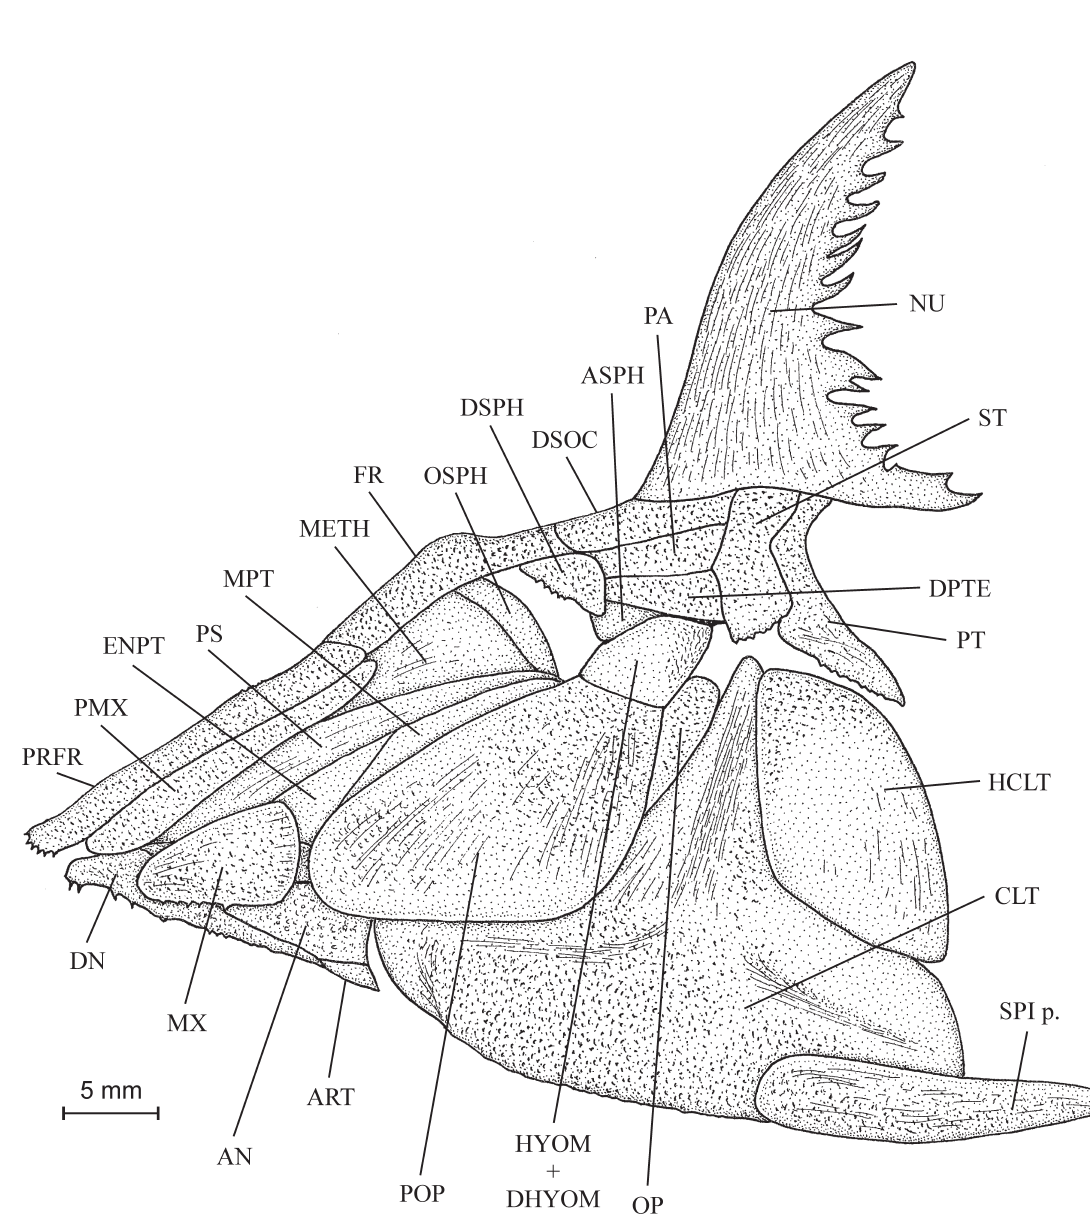
Fig. 9. Monocerichthys scheuchzeri gen. et sp. nov. Reconstruction of the skull and the pectoral girdle based on the two faces of holotype CLC S-413a,